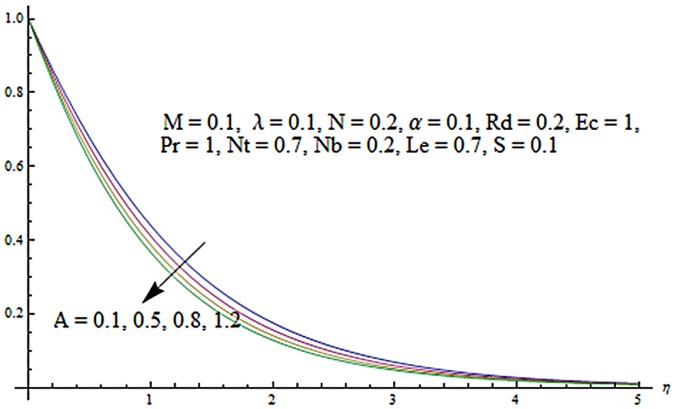
Influence of A on θ.